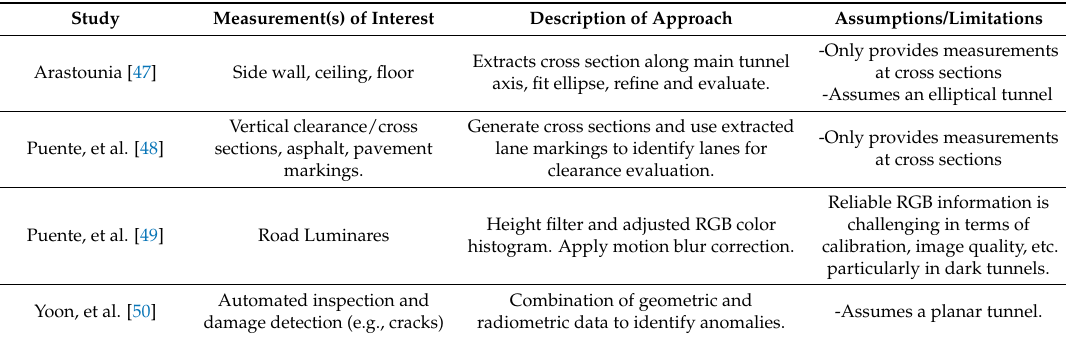
Table 2. Descriptions of object extraction techniques for